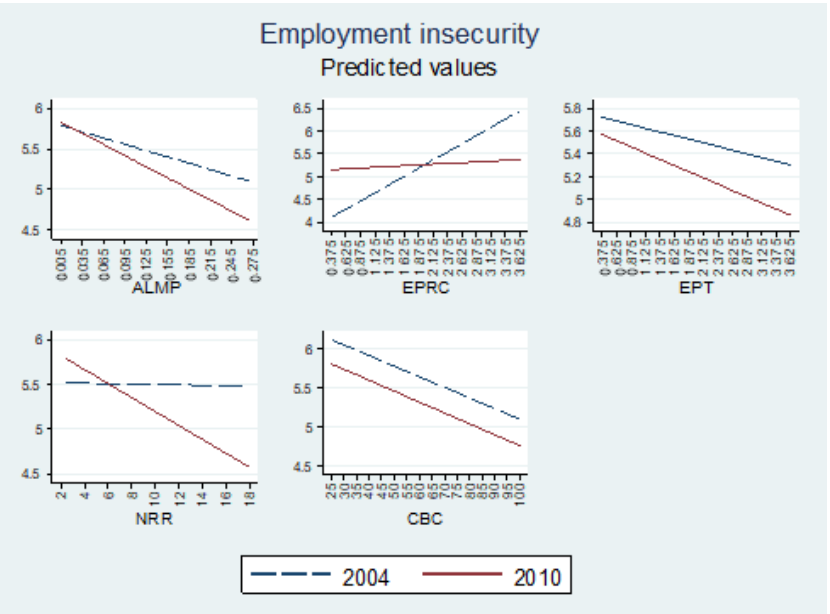
Figure 3. Institutions, employment insecurity, and the crisis. Source: Pooled data from the second and fifth waves of the European Social Survey. Notes: (1) For EPRC and EPT, the sample includes only temporary workers. (2) Predicted probabilities were plotted with the full set of controls. All control variables are set to their mean. (3) Likelihood ratio tests (Prob > Chi 2 ) for whether the interaction effect is statistically significant: ALMP = 0.01; EPRC = 0.01; EPT = 0.02; NRR = 0.00; CBC = 0.81. Confidence intervals are available upon request.